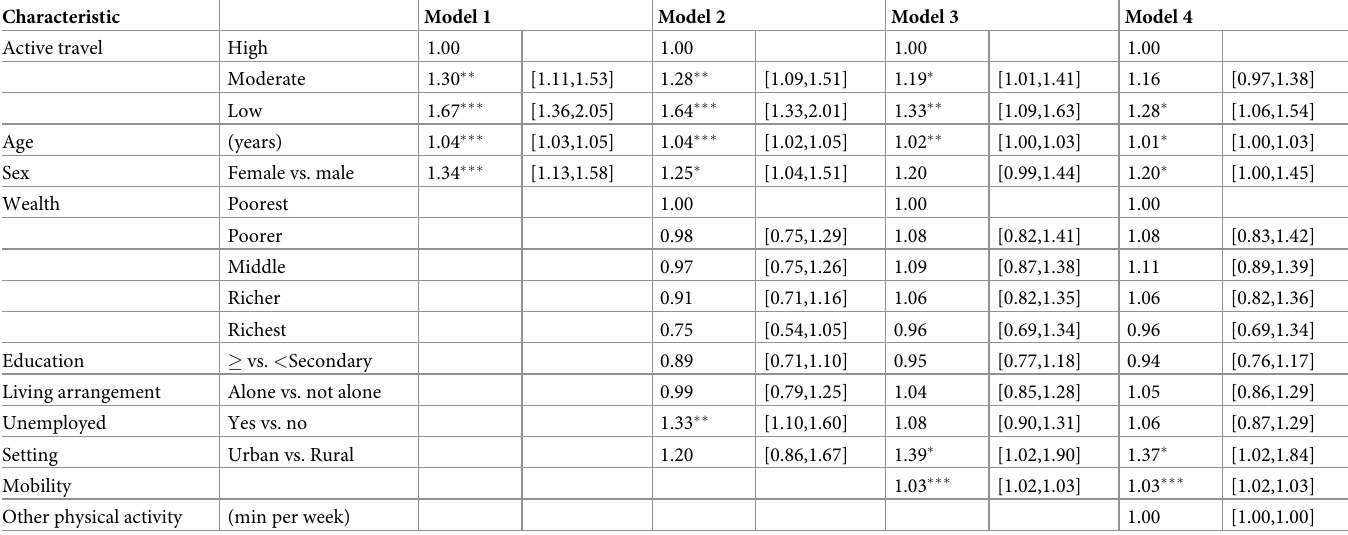
Other physical activity (min per week) Data are odds ratio [95% confidence